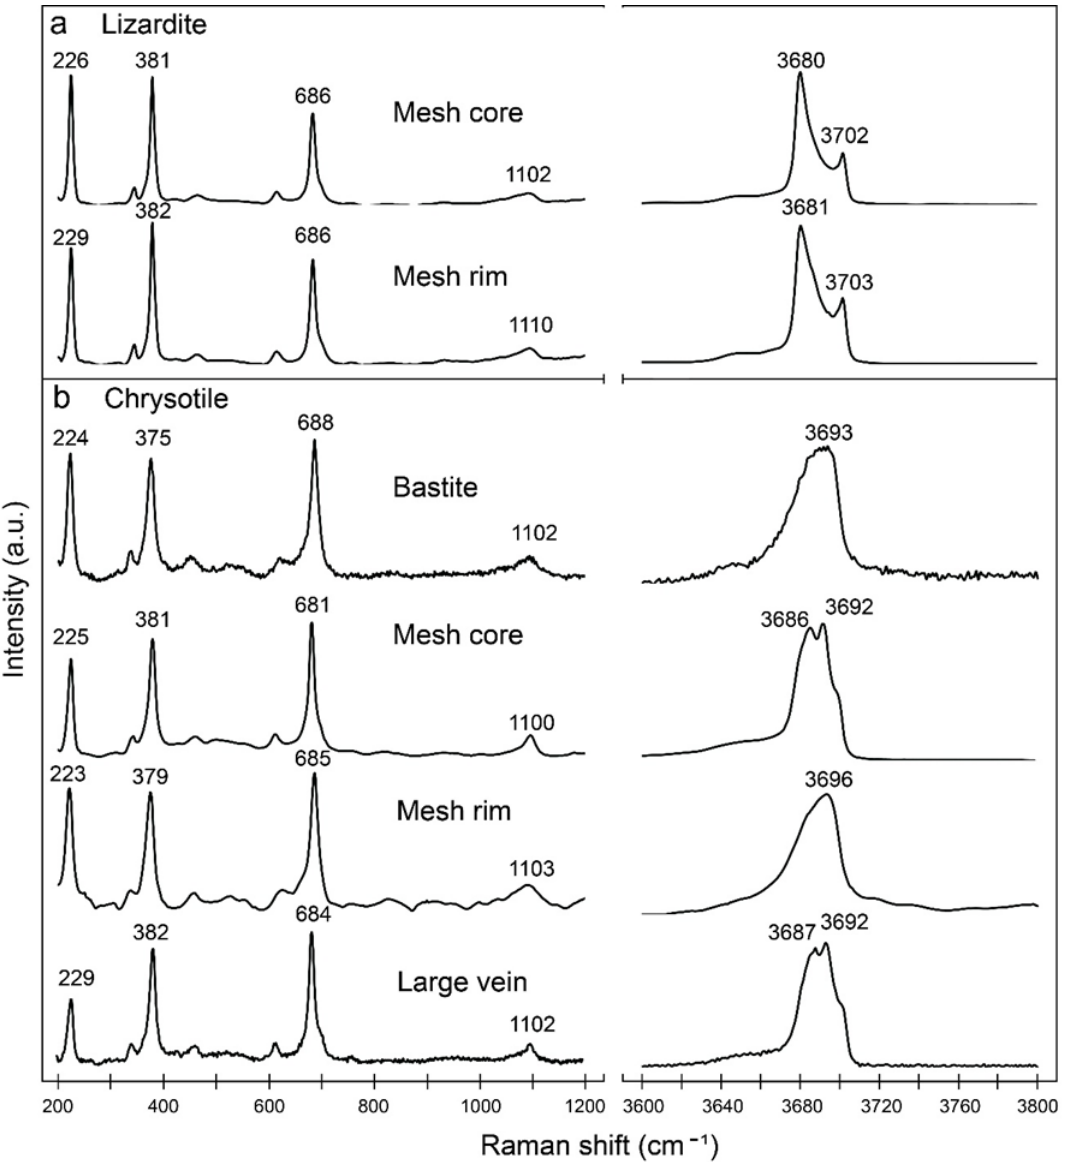
Fig. 2. Representative Raman spectra of the serpentine minerals. (a) Lizardite (mesh texture core and rim). (b) Chrysotile (bastite, mesh texture core, vein in mesh texture, and large